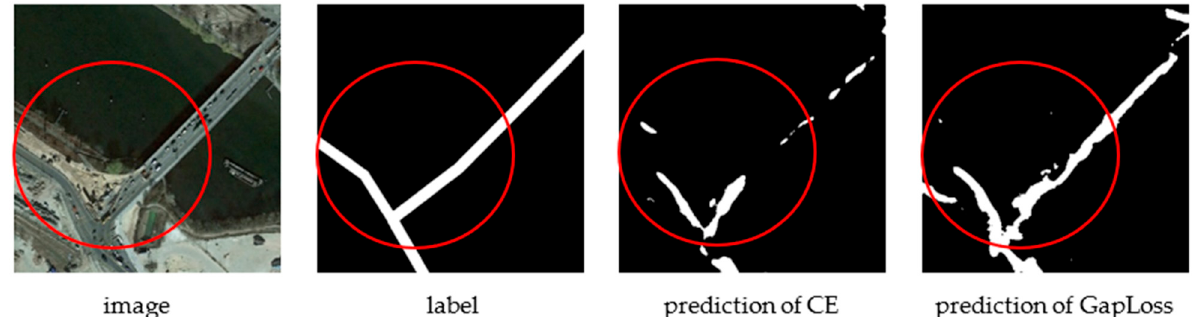
Figure 12. Unet++ results with CE and GapLoss on Aerial Image Segmentation Dataset.